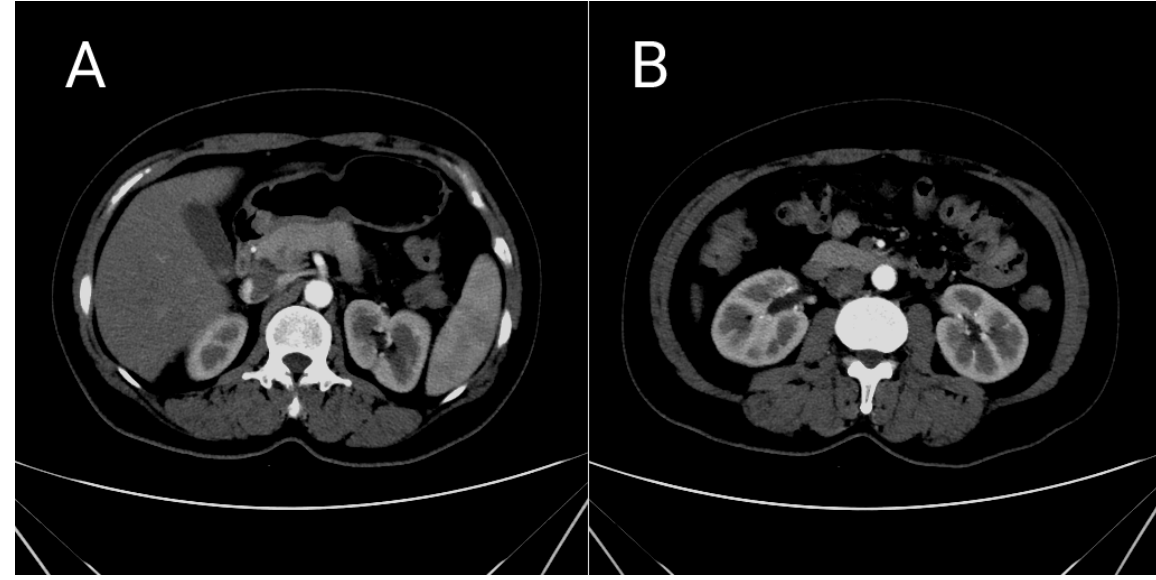
Figure 1: CT Abdomen with IV Contrast The coronal image of contrast-enhanced CT scan revealed that the lesion was within normal limits, and the gastric wall was poor filling. On transverse, the intestinal tract is normal. There was no sign of ileus. CT= Computed Tomography; IV=